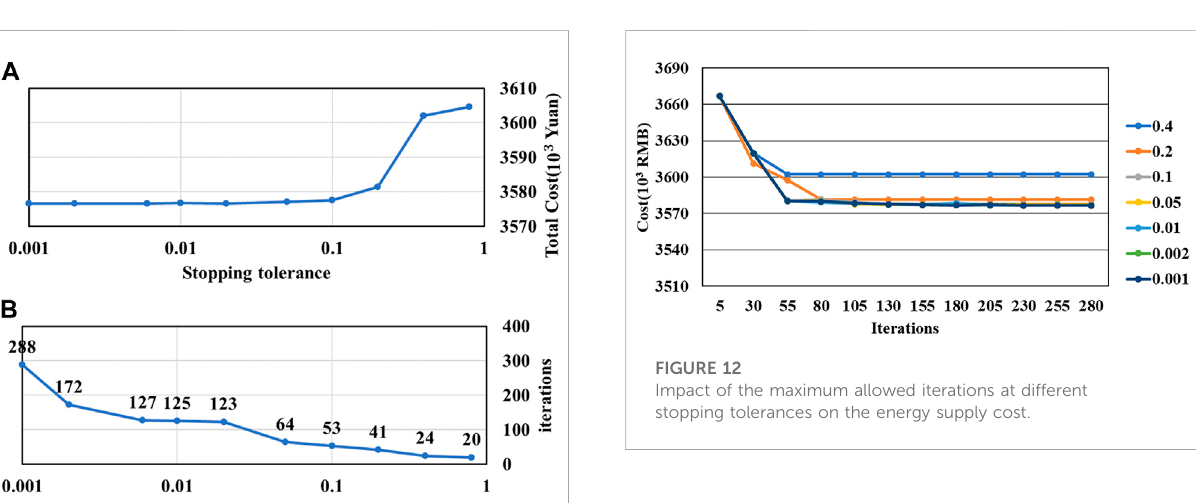
FIGURE 11 The results of convergence analysis on stopping tolerance. The impact of stopping tolerance on the total cost and the required iteration number are shown in (A,B) , respectively.